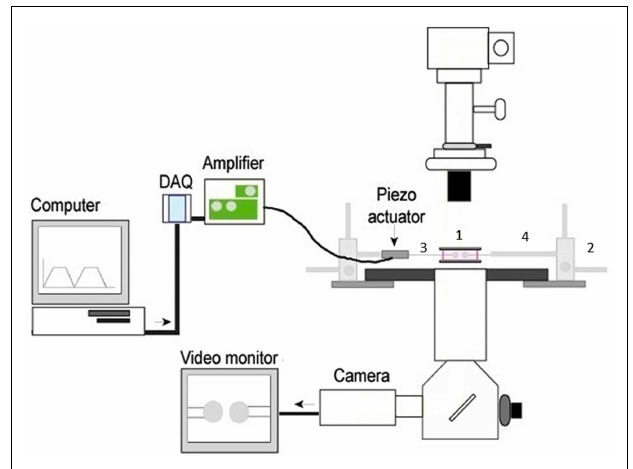
FIGURE 1 |The basic 2D micropipette adhesion frequency assay system .The foundation for this system is an inverted microscope.The stage has been modified with a metal adapter (1) to rest a media filled chamber containing theT cells and pMHC coated RBCs above the 100 × oil immersion objective lens.The stage is also fitted with course micromanipulators (2) allowing for the movement of the micropipettes (3) within the chamber.The micropipettes are attached to a hydraulic pressure system (not shown) by means of a micropipette holder (4) allowing for individual cells to be aspirated and held within the chamber. A piezoelectric actuator is attached to one micropipette holder such that it can be moved in and out of contact with the opposing cell.The DAQ, digital acquisition board, converts the cyclical digital signal from a computer program to an analog voltage signal that drives the piezoelectric actuator. Cells can be visualized on the video monitor and adhesion events can be subsequently